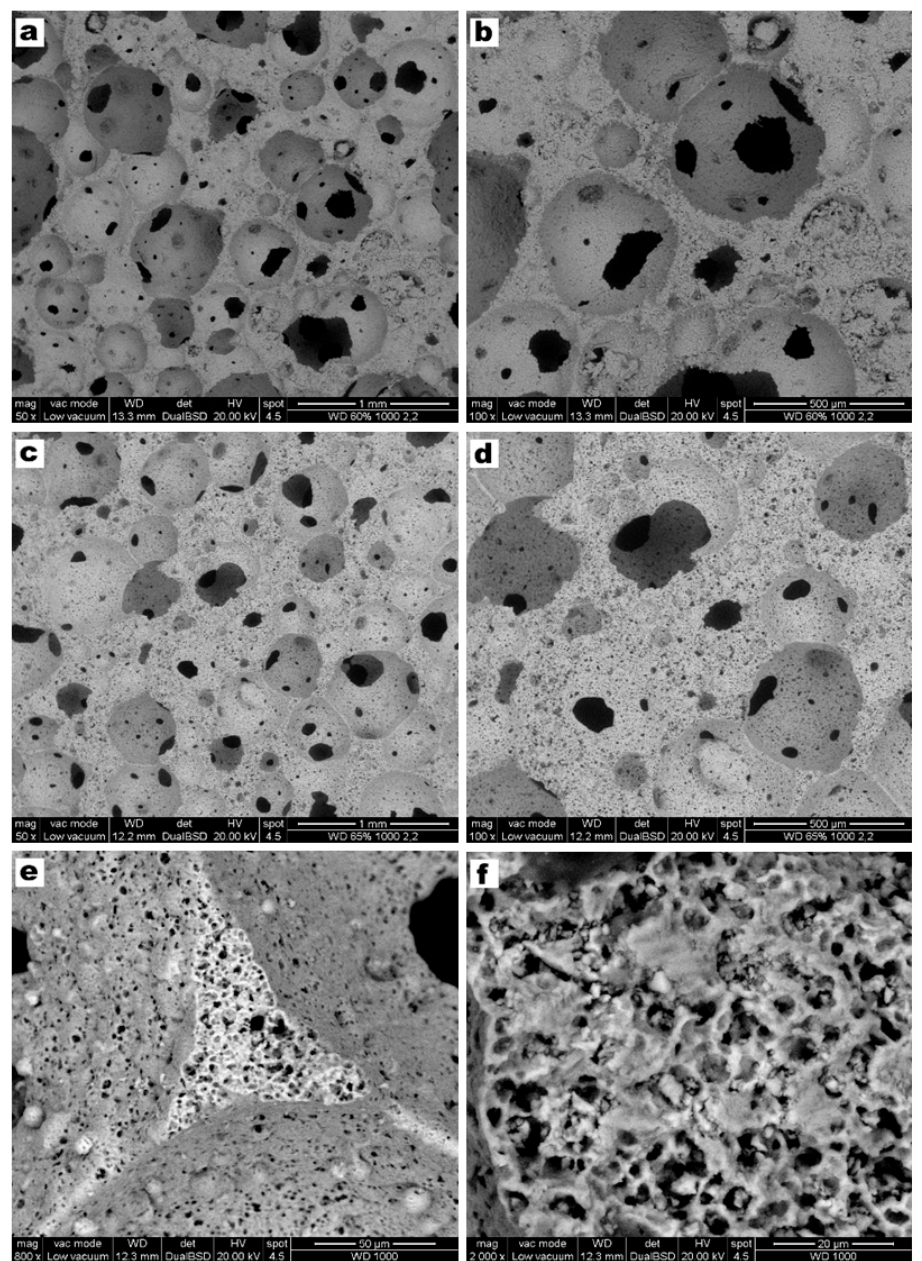
Figure 7. SEM images of W-D glass-ceramic foams with different solid content and after firing at 1000 °C ( a , b ) for foams with 60 wt % solid load; ( c , d ) for foams with 65 wt %; ( e , f ) high magnification details of cell struts.